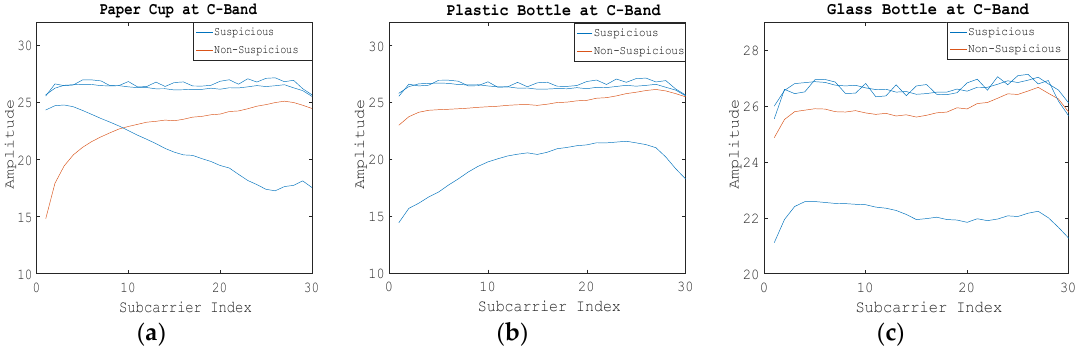
Figure 4. Amplitude information of 30 subcarriers of Step 1 at the C-band. ( a ) Using the paper cup; ( b ) Using the plastic bottle; ( c ) Using the glass bottle. The conclusion of the S-band was the same, as shown in Figure 5.